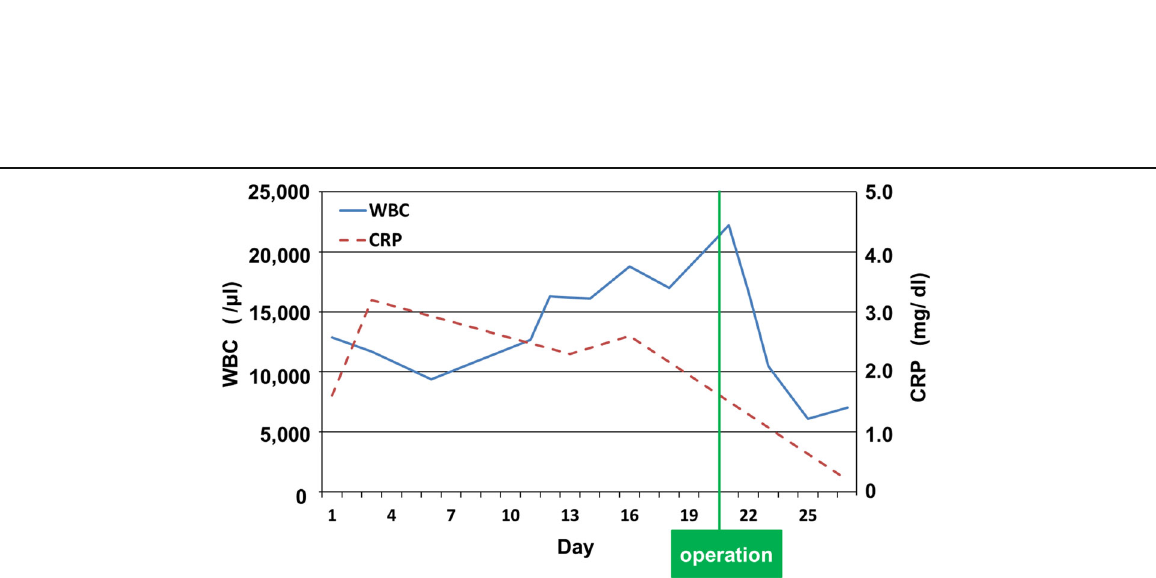
Fig. 4 The trends of white blood cell (WBC) count and C-reactive protein (CRP) levels. Both values are normalized